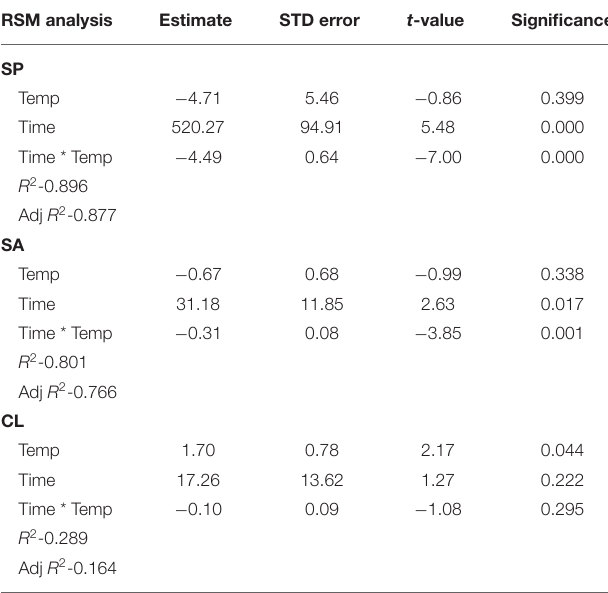
TABLE 2 | Response surface analysis of time-temperature pre-treatment on